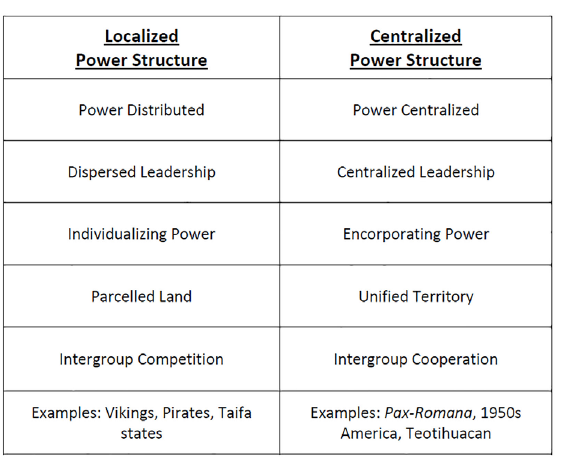
Figure 1. Figure showing the characteristics of localized and centralized power structures with examples of societies that embody them. While these examples serve a purpose, it should be noted that they are extreme examples and typically